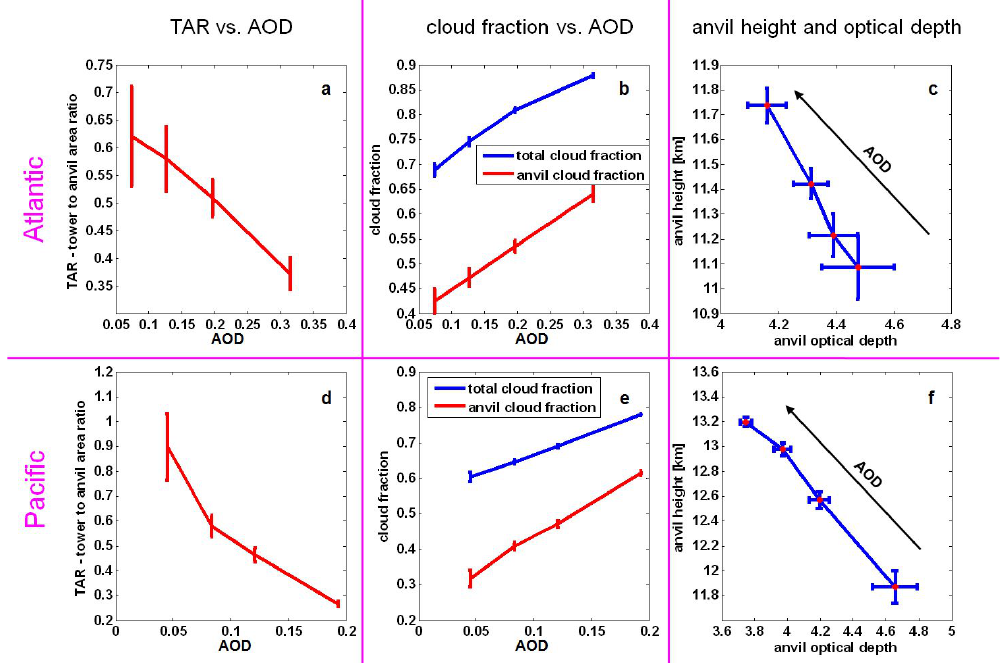
Fig. 3. Relationships between deep convective cloud characteristics and aerosol loading. Top row refers to the Atlantic study region (0 ◦ N to 14 ◦ N; 18 ◦ W to 45 ◦ W). Bottom row refers to the Pacific study region (0 ◦ N to 14 ◦ N; 180 ◦ W to 150 ◦ W). Left column – (a) and (d) , tower to anvil area ratio as a function of aerosol optical depth (AOD). Center column – (b) and (e) , cloud fraction as a function of AOD. The blue curve shows the total cloud fraction. The red shows only the anvil cloud fraction. Note the similarity in slopes. The change of total cloud fraction with aerosol is driven by the expansion of the anvils, and the decrease in the relative contribution of the towers. Right column, (c) and (f) , anvil height and anvil optical depth for the four levels of aerosol loading marked in left figures. The low level AOD is associated with the lower right dot. The black arrow marks the AOD increase direction. Increase in aerosol loading is associated with increase of anvil height and with a decrease in anvil optical depth or a thinning of the anvil as it spreads